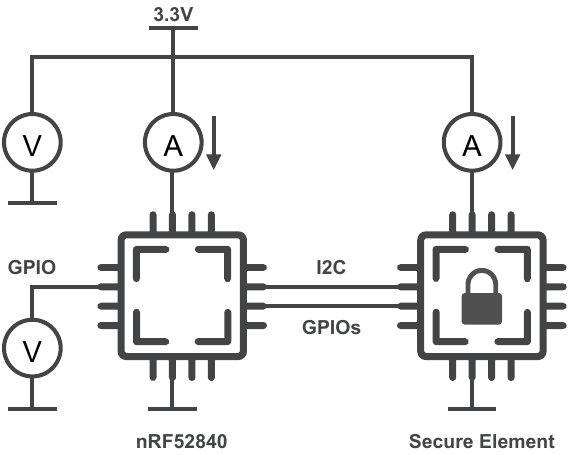
Figure 6. Conceptual measurement setup of the node for acquiring the execution time and energy consumption during the stated test